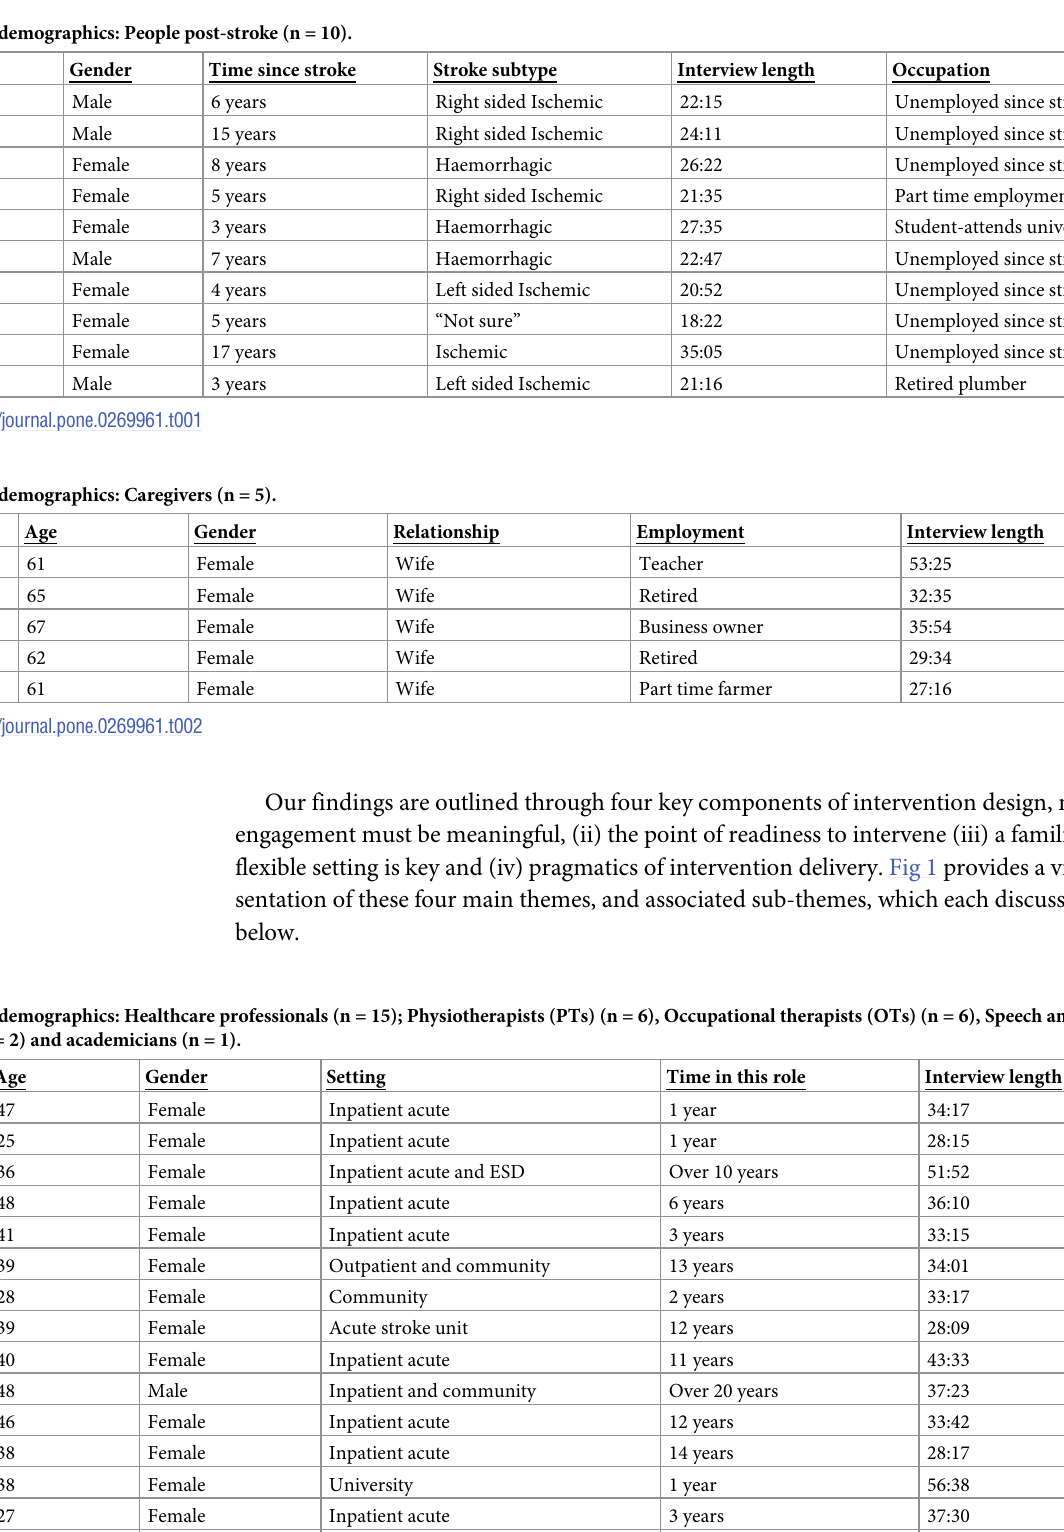
Table 1. Participant demographics: People post-stroke (n = 10).